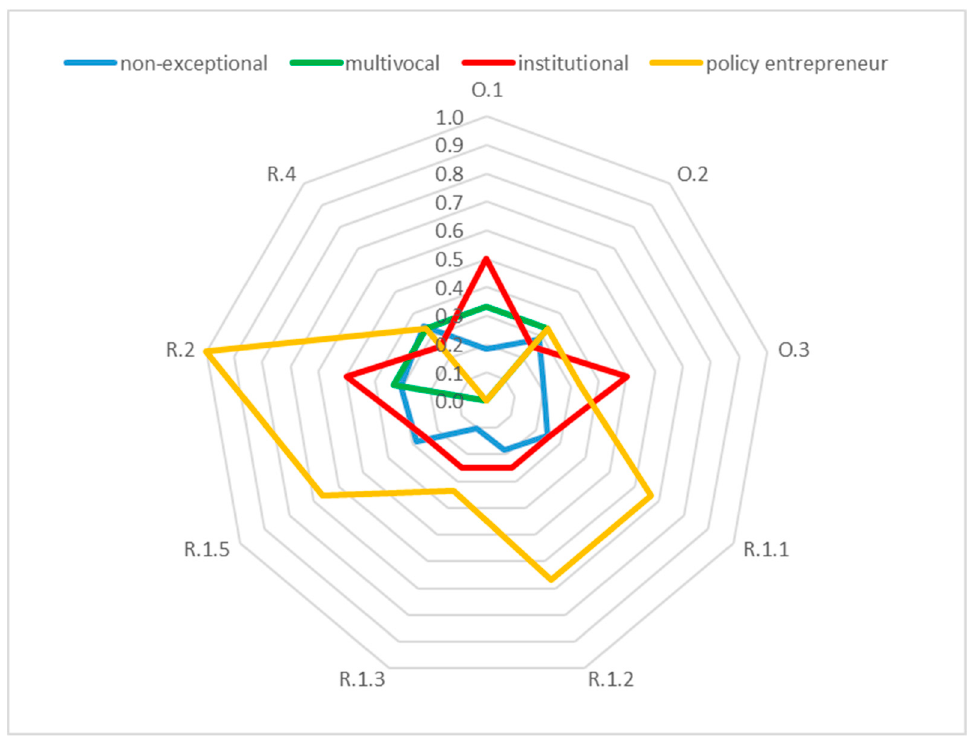
Figure 5. Exceptional actors and land tenure attitudes.